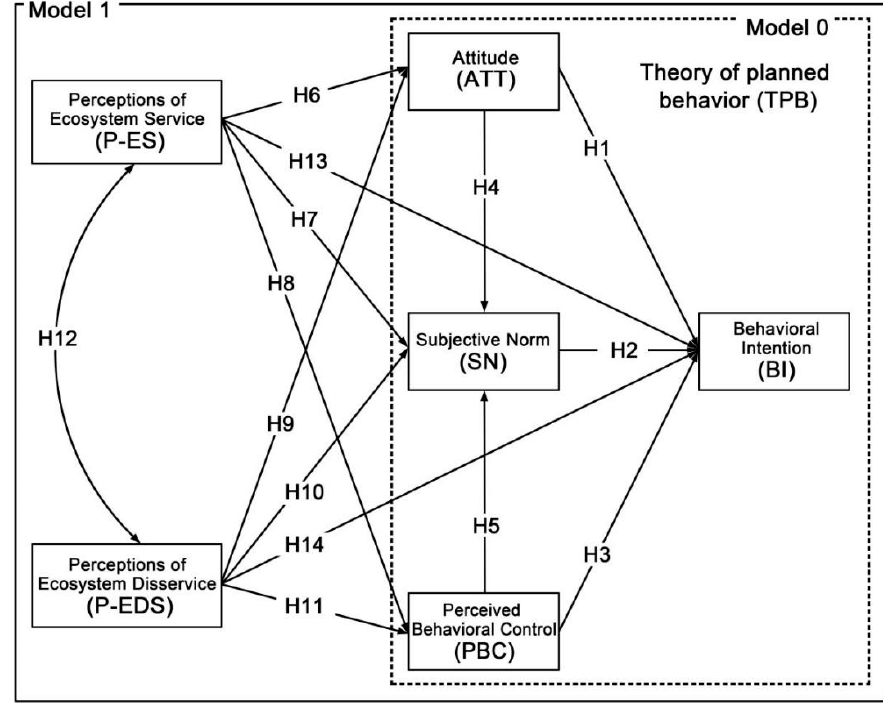
Figure 1. The initial conceptual diagram of urban residents’ behavioral intention for UCGs.